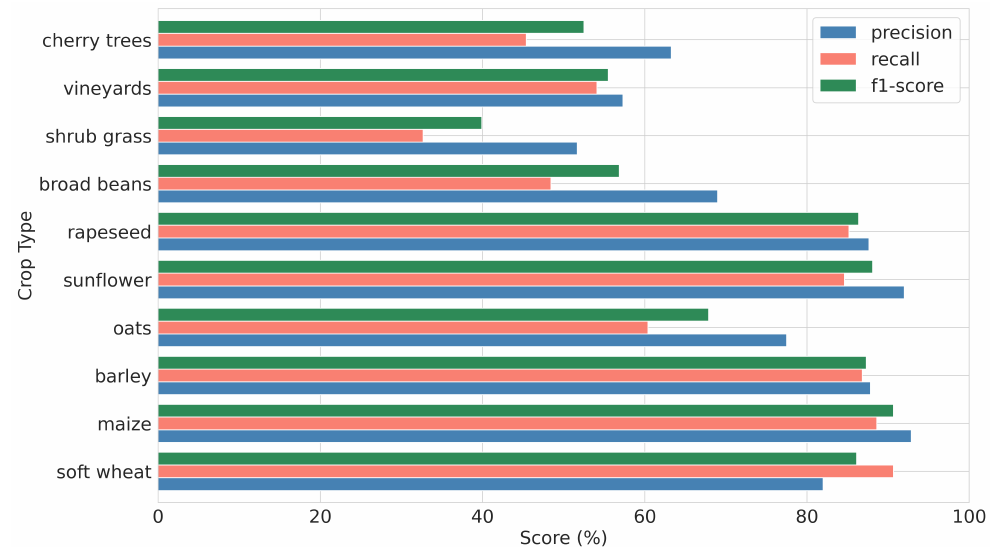
Figure 6. Classification metrics for the different crop type of the S1